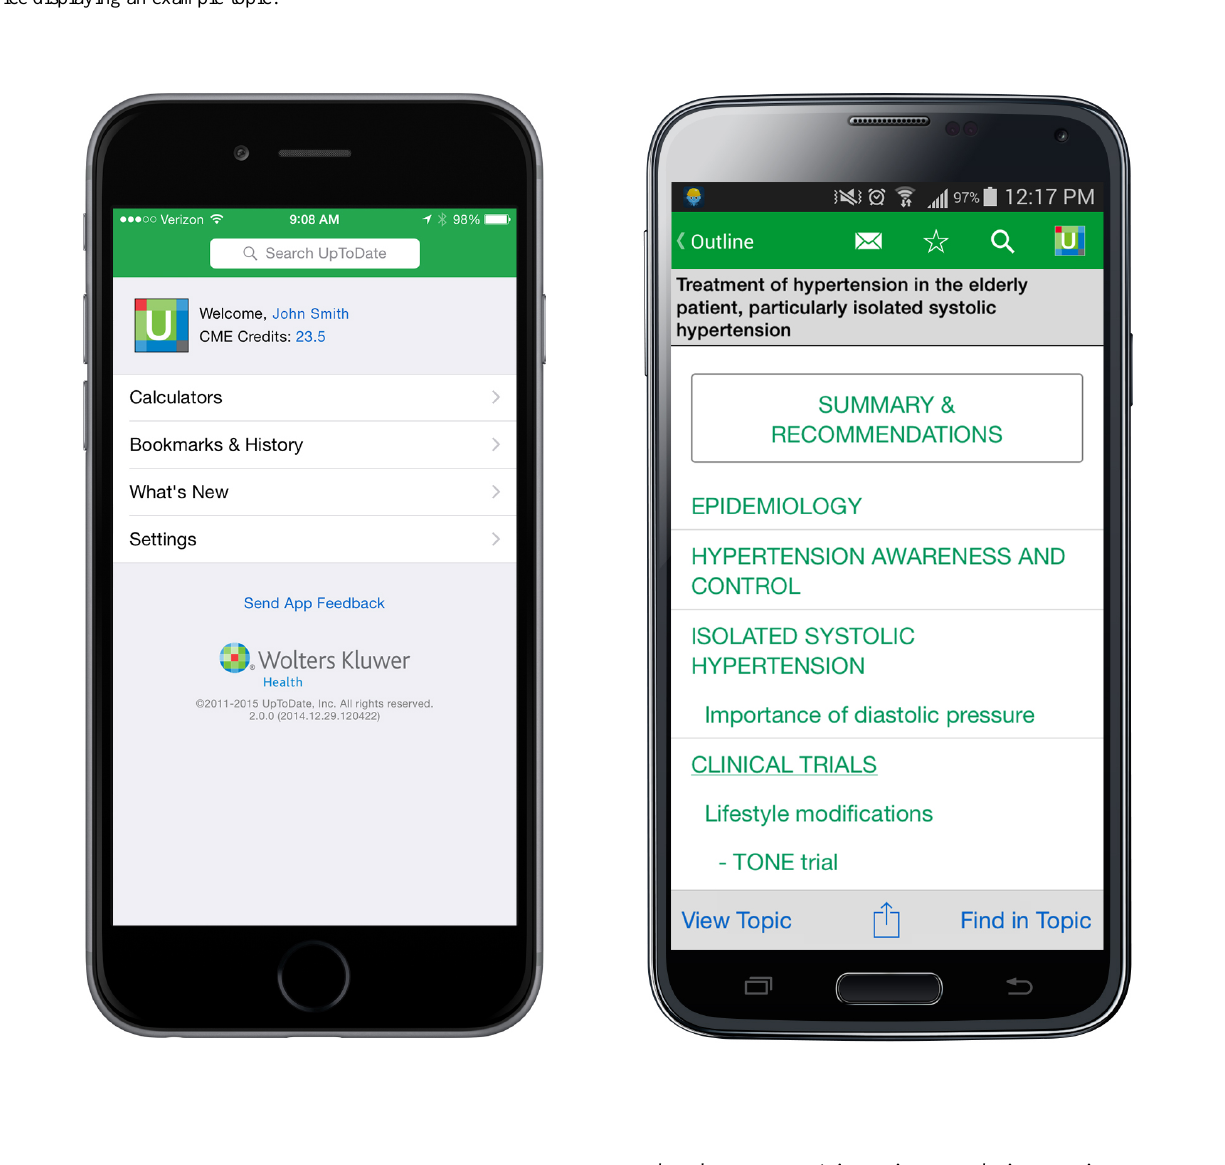
Figure 1. An example of a clinical decision support system on mobile phones (UpToDate) on a smartphone displaying the home page and an Android device displaying an example